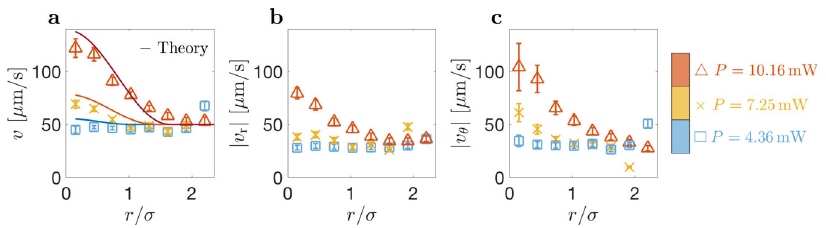
Fig. 3 Particle velocity dependence on radial position and laser power. a The particle ’ s total velocity v follows the intensity pro fi le of the laser beam indicated by solid lines given by Eq. (2), where u 0 = 23.7, 60.5 and 131.6 μ m s − 1 for P = 4.36 (blue, square markers), 7.25 (yellow, x markers), and 10.16 mW (orange, triangle markers), respectively, taken from fi ts of ρ ( r ) in Fig. 2. Similarly, b the absolute radial velocity ∣ v r ∣ and, c the absolute azimuthal velocity ∣ v θ ∣ follow the intensity pro fi le of the beam. Data is taken from a single 1-s trajectory sampled at 719 Hz. Each data point is an average over the times the particle passes through that value of r / σ . Error bars are the standard error of the mean.